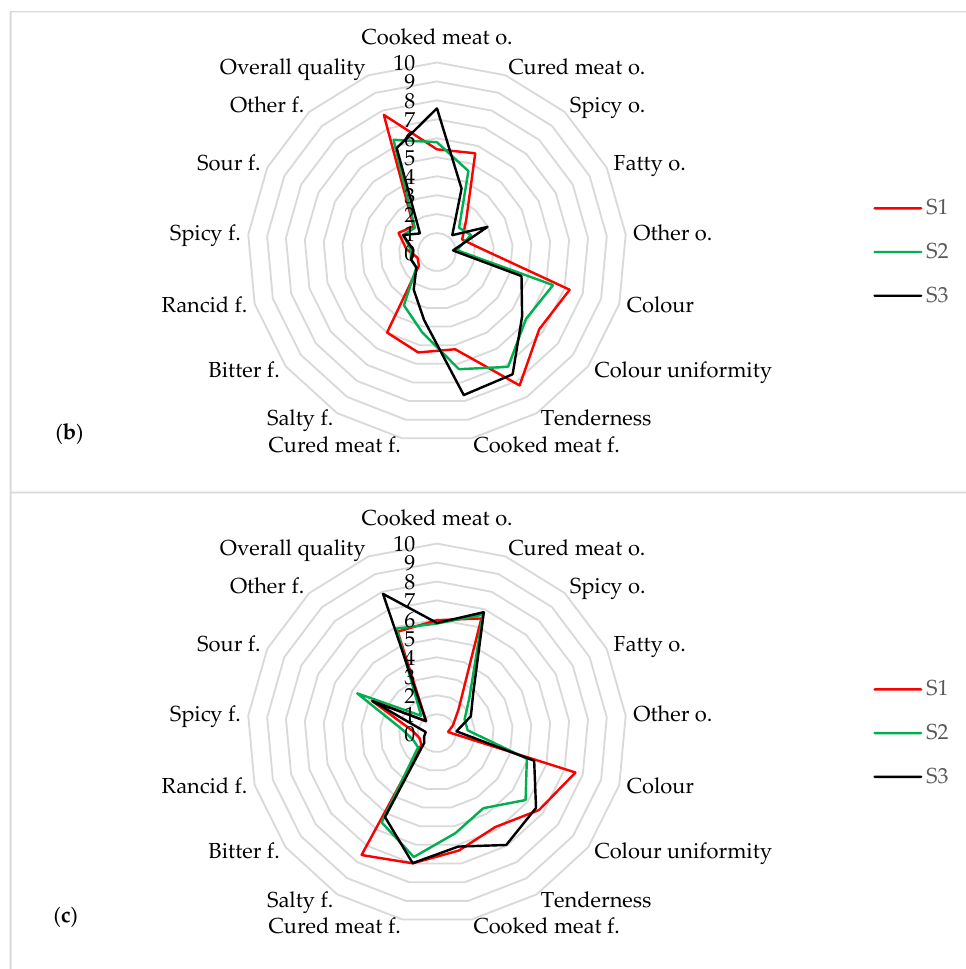
Figure 4. Sensory analyses of the tested pork hams immediately after production ( a ), after 7 days ( b ) and 14 days ( c ) of storage. o.—odour, f.—flavour.